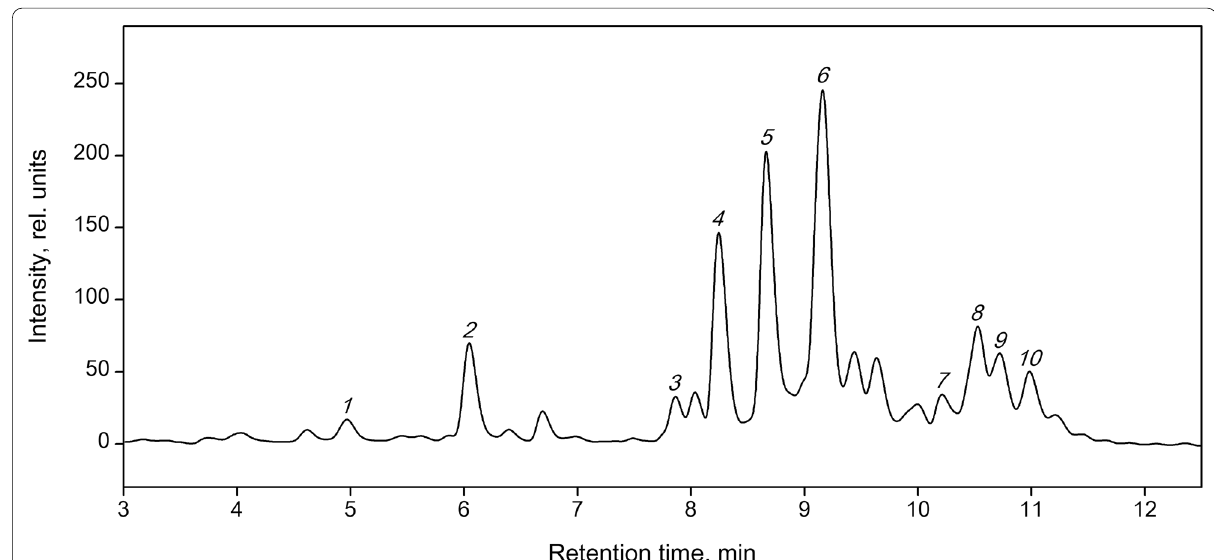
Fig. 5 Typical chromatogram of the methanol extract of astaxanthin esters from H. pluvialis cells after 12 days of cultivation under stress conditions: (1) free astaxanthin; (2) lutein; (3)